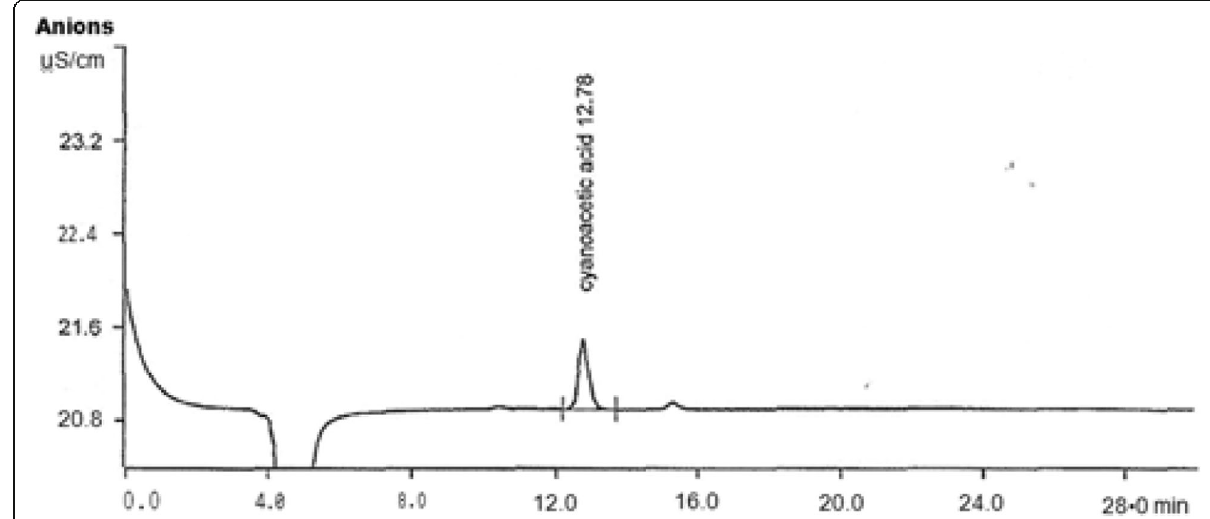
Fig. 4 A typical representative chromatogram of CAA standard